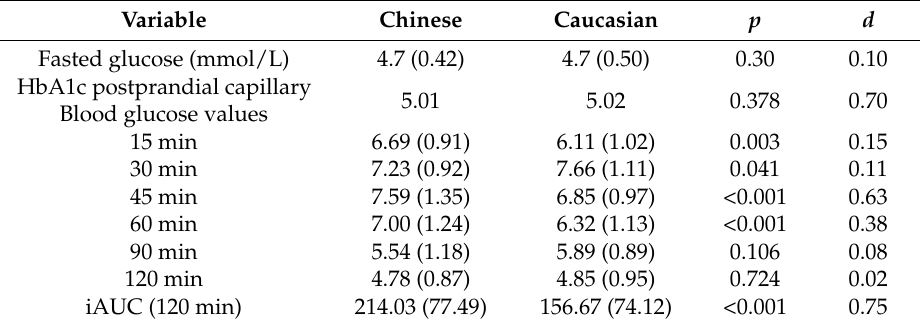
Table 4. Main outcome measures. iAUC: incremental area under the